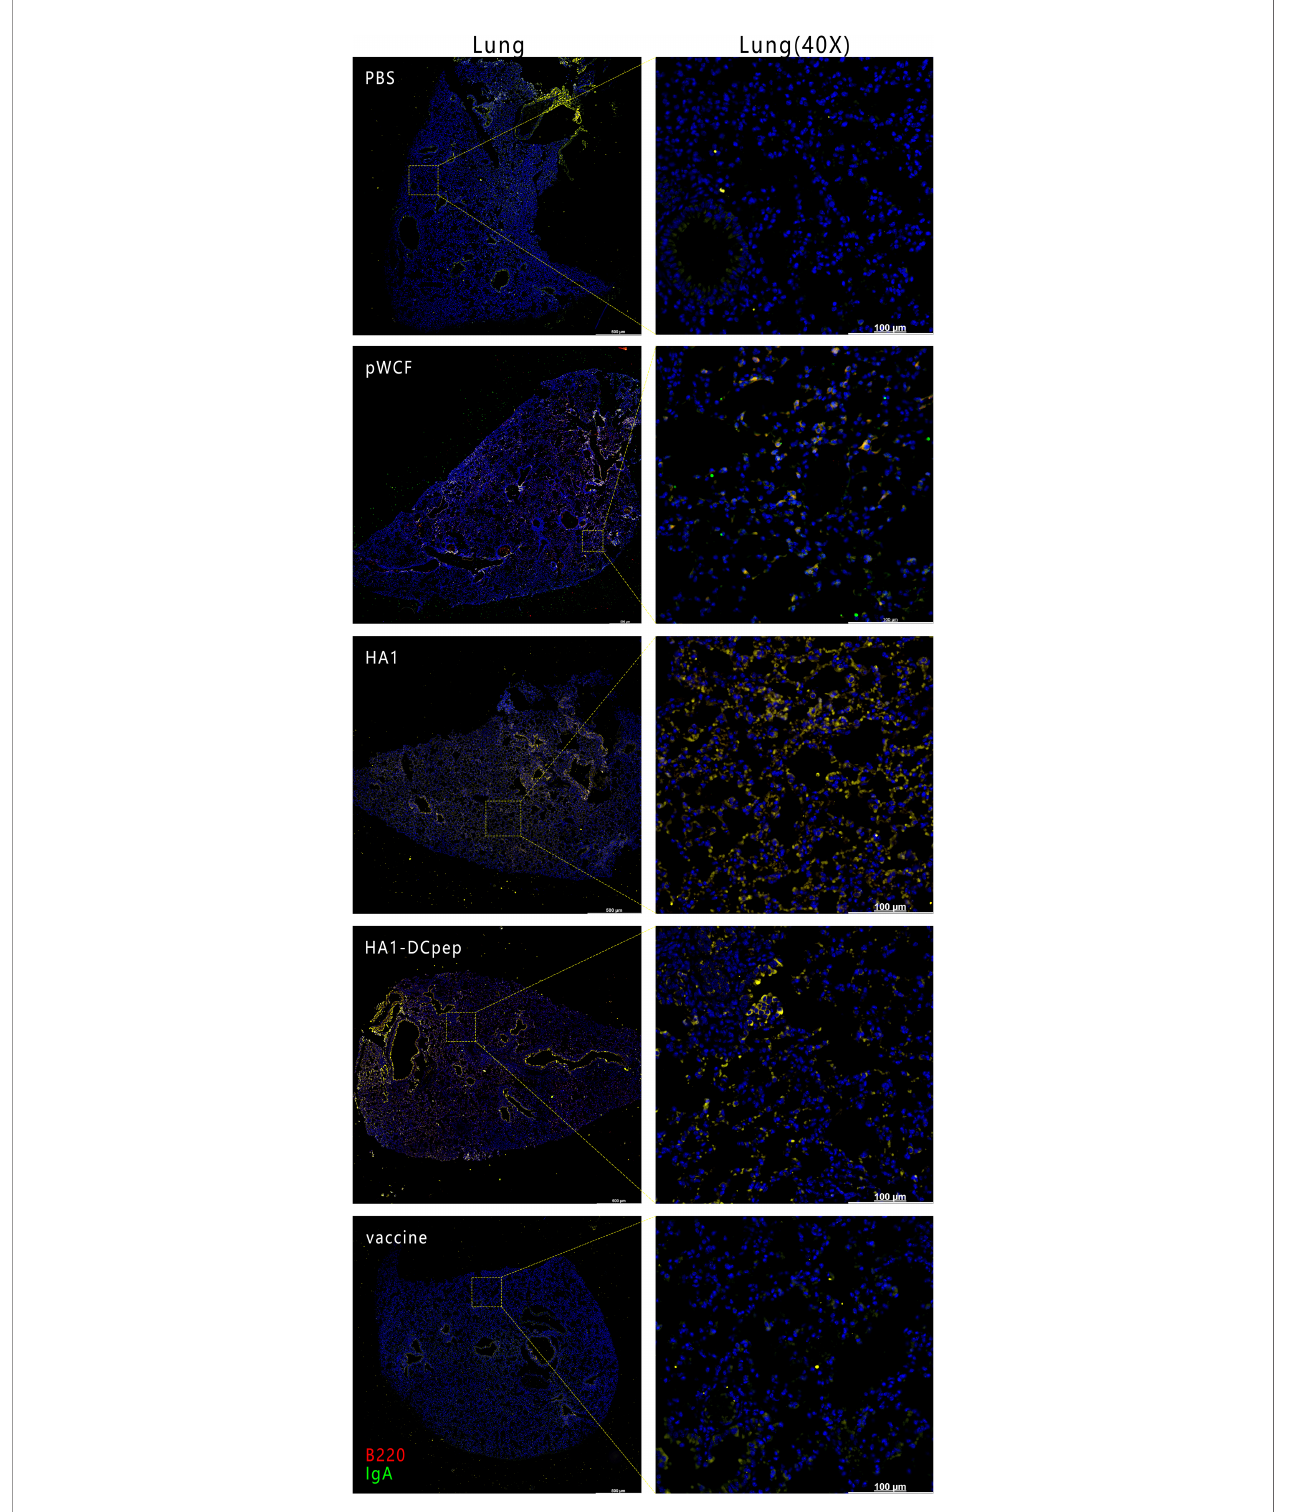
FIGURE 7 | Recombinant L. plantarum increase IgA expression in the lungs of mice. After oral immunization of mice with recombinant L. plantarum , IgA expression was measured in the lungs using anti-B220 (red) and IgA (green) antibody staining and immuno fl uorescence techniques. B220 + IgA + cells were stained yellow. Lung scale bars represent 500 m m (left) and 100 m m